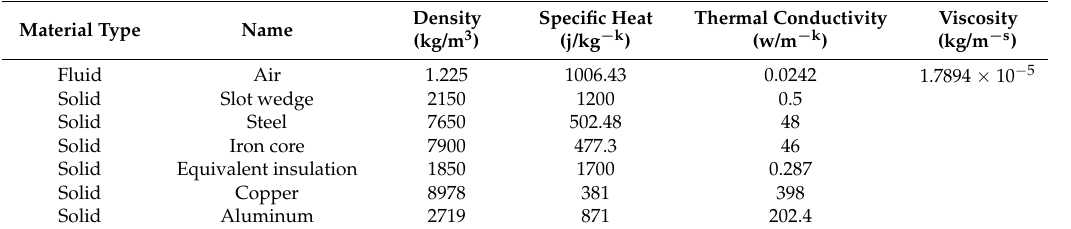
Table 2. Properties of